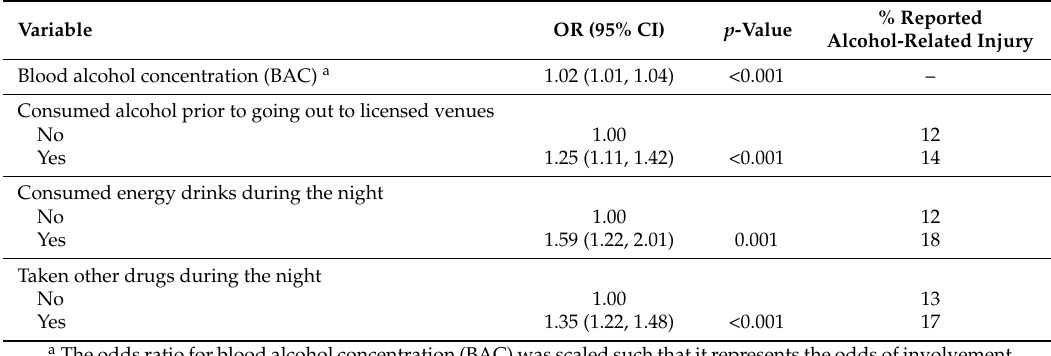
Table 3. Multivariate logistic regression models examining current night out substance use associated with involvement in a non-violent alcohol-related injury in the past three